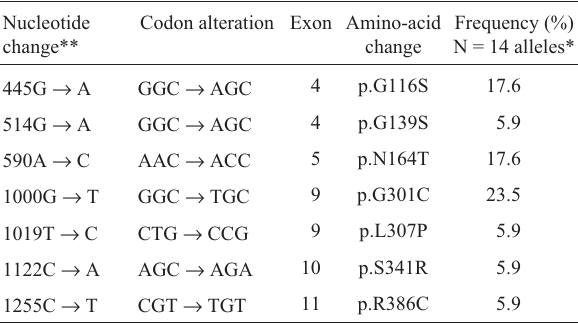
scent (consanguineous